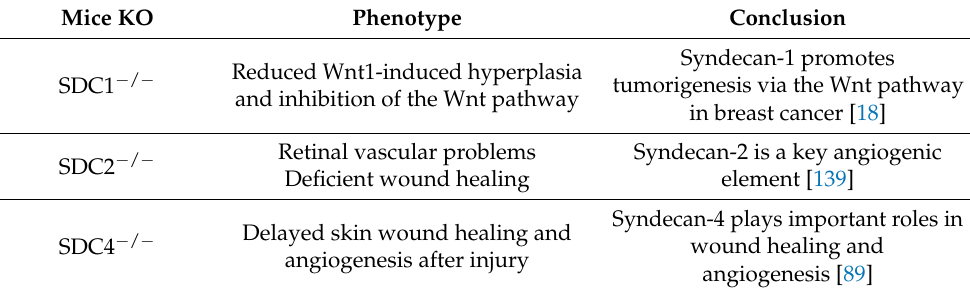
Table 2. Mice models to study syndecan